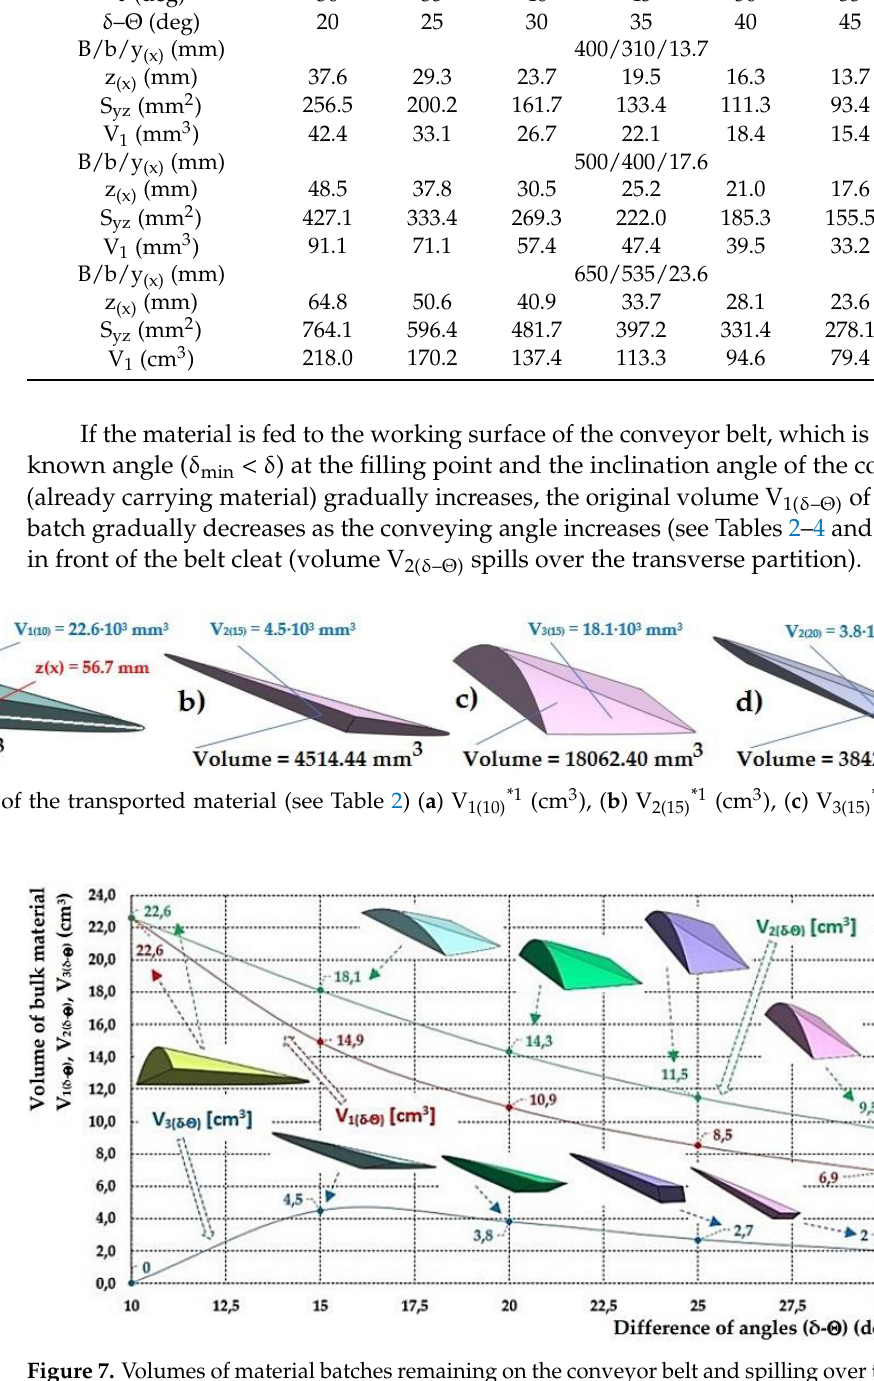
Figure 7. Volumes of material batches remaining on the conveyor belt and spilling over the